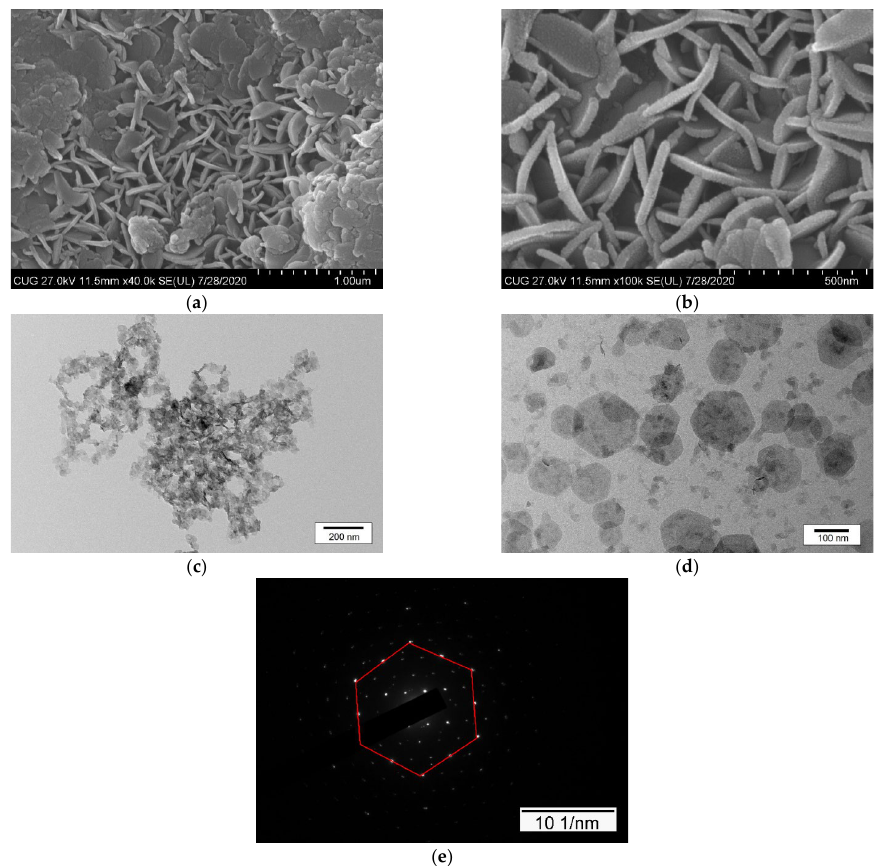
Figure 11. The SEM images ( a , b ) of delaminated iron-based LDH after tungstate sorption showing crystalline morphology and TEM ( c , d ) and the corresponding SAED pattern ( e ).